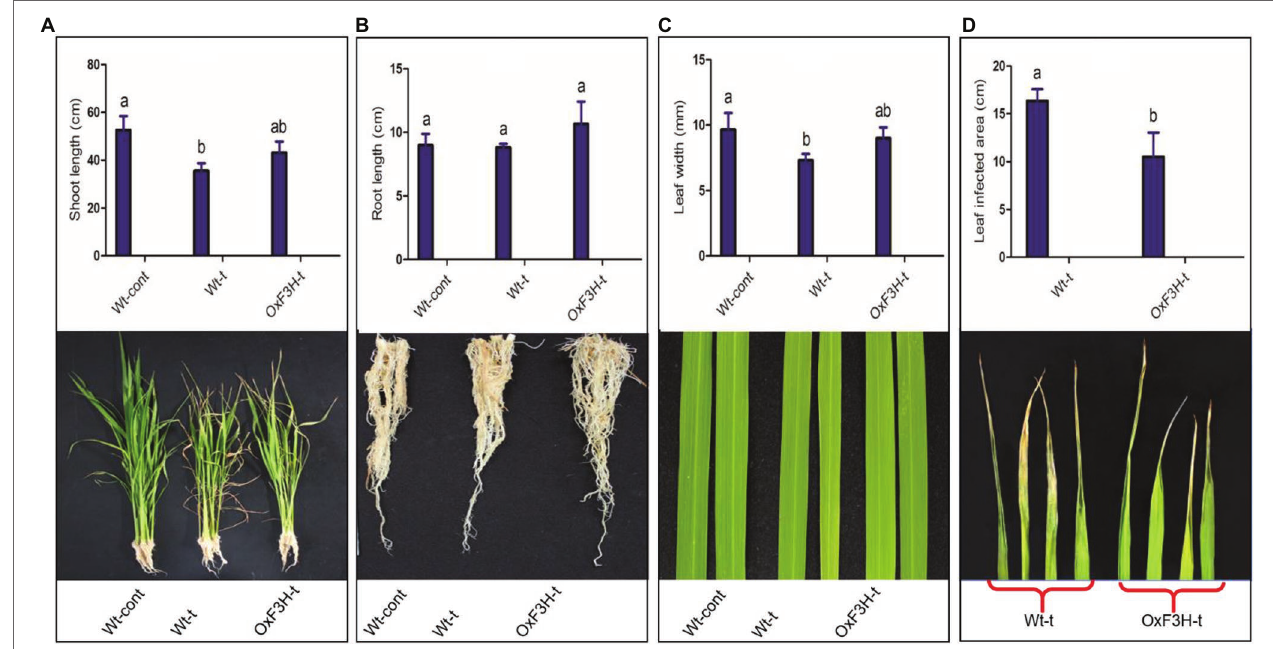
FIGURE 1 | Evaluation of growth parameters of Wt-cont, Wt-t, and OxF3H-t plants. (A) Shoot length, (B) root length, (C) leaf width, and (D) leaf tip damage following stress exposure. Lower panels show photographic representations of each phenotype. Different letters above the bars represent significant differences ( p ≤ 0.001) as determined by Duncan’s multiple range